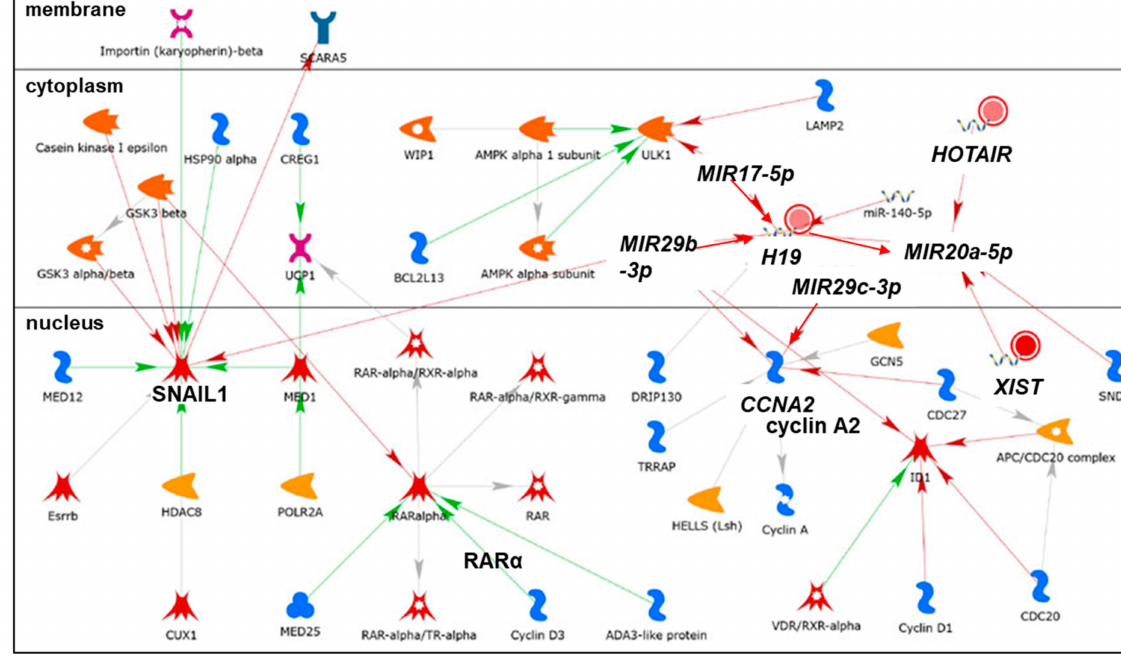
Figure 12. Network 4: H19, XIST, HOTAIRM1, SNAIL1 , and cyclin A2 ( CCNA1 ), identified in lncRNAs differentially expressed in MCF-7 and or LCC9 cells by MetaCore analysis. Green lines with arrows = stimulation; red lines with arrows =